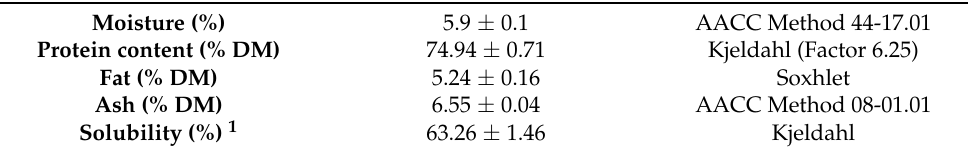
Table 1. Compositional analysis and solubility of the red lentil protein isolate (from Vogel- sang et al. [25]), and methods used for analysis.